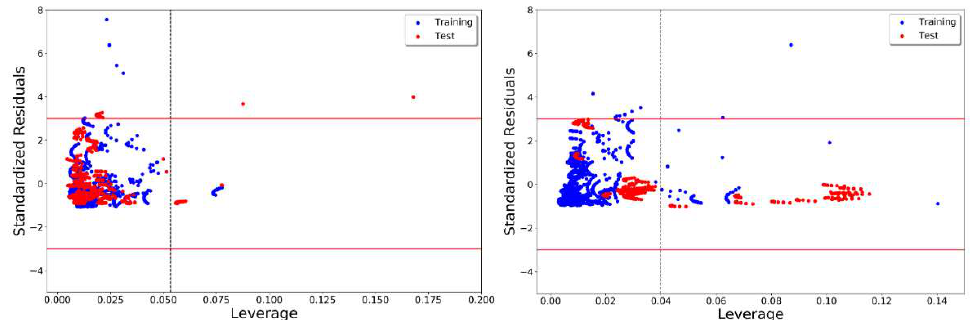
Figure 4. Williams plots of the best mixtures-out validation-based model, MO59 (left), and the best compounds-out validation-based model, CO15 (right).